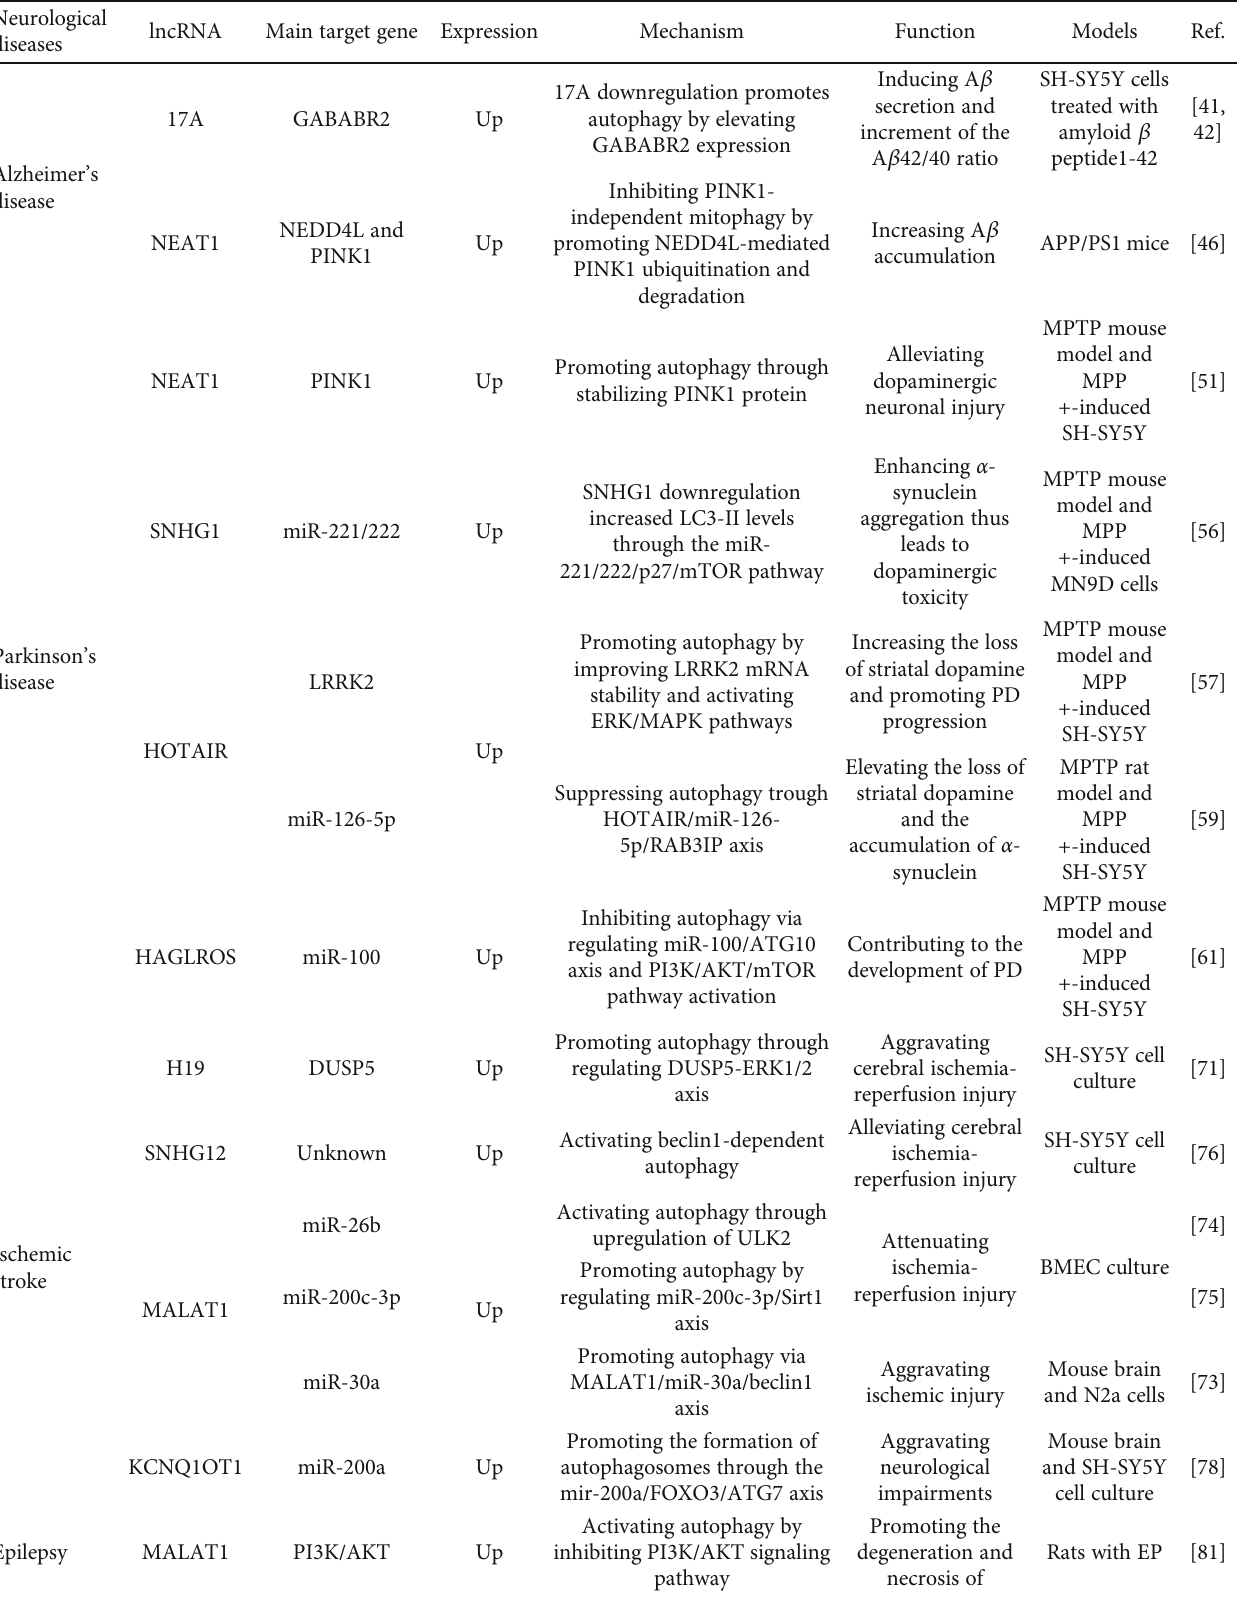
Table 1: lncRNAs associated with autophagy regulation in neurological